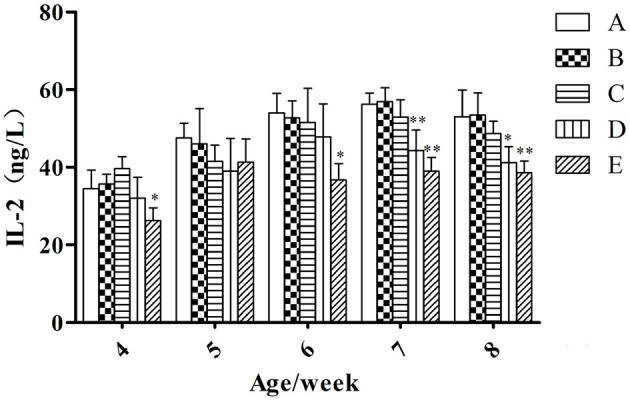
IL-2 concentration under different hygienic conditions (n = 60). *Means that the difference between treatment groups (B–E) and control group (A) was significant. **Means that the difference between treatment groups (B–E) and control group (A) was extremely significant.